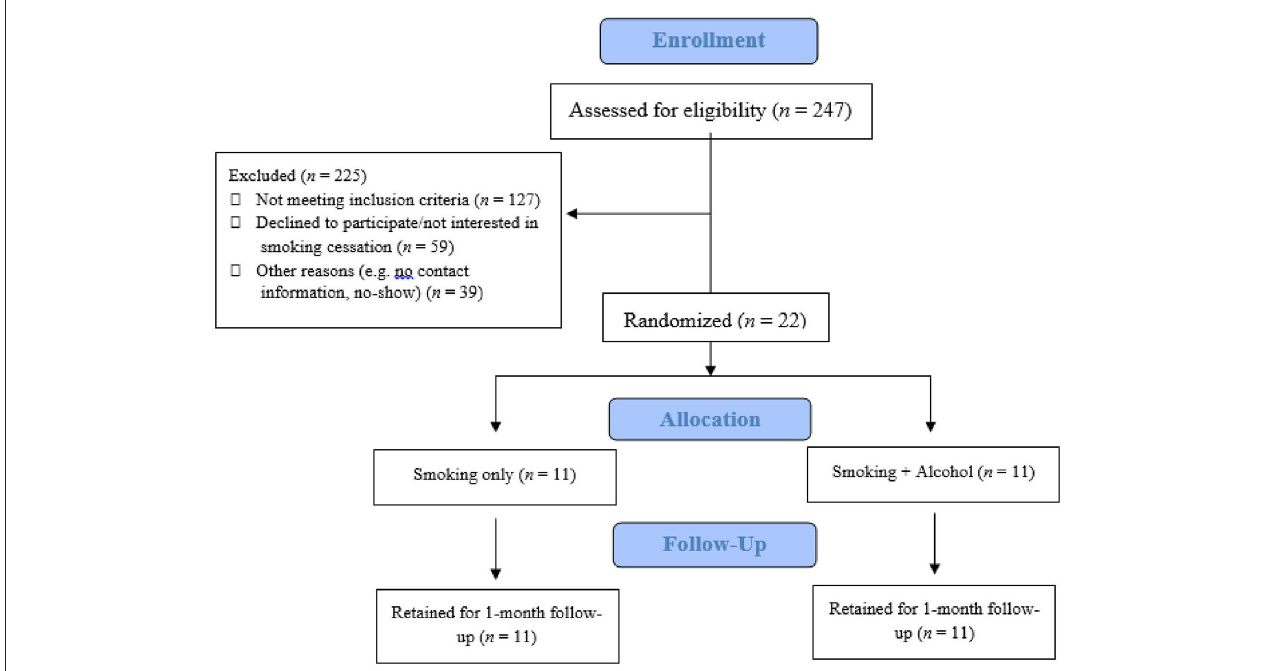
FIGURE 1 | CONSORT